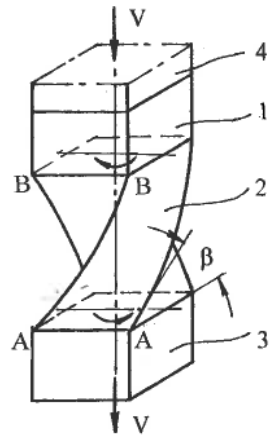
Figure 17. Twist-extrusion (TE).